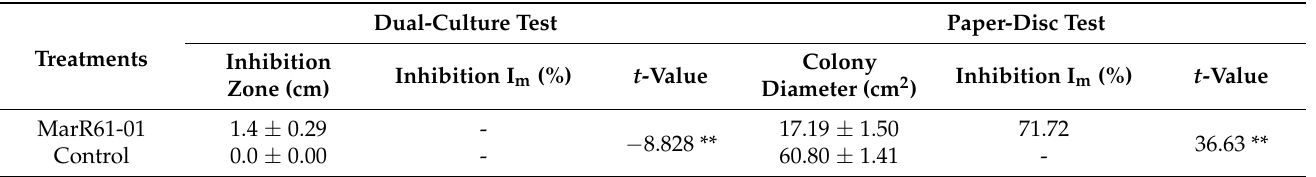
Table 1. Inhibitory effect of Serratia rubidaea MarR61-01 against Botrytis cinerea under in vitro tests.